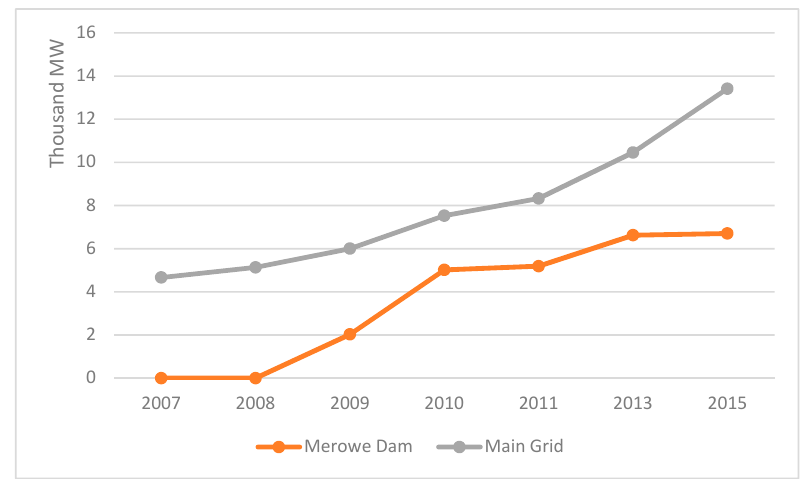
Figure 4. Electricity production in Sudan Merowe Dam and other sources. Source: Dam Implementation Unit (DIU) 2017. Merowe Dam Main Grid